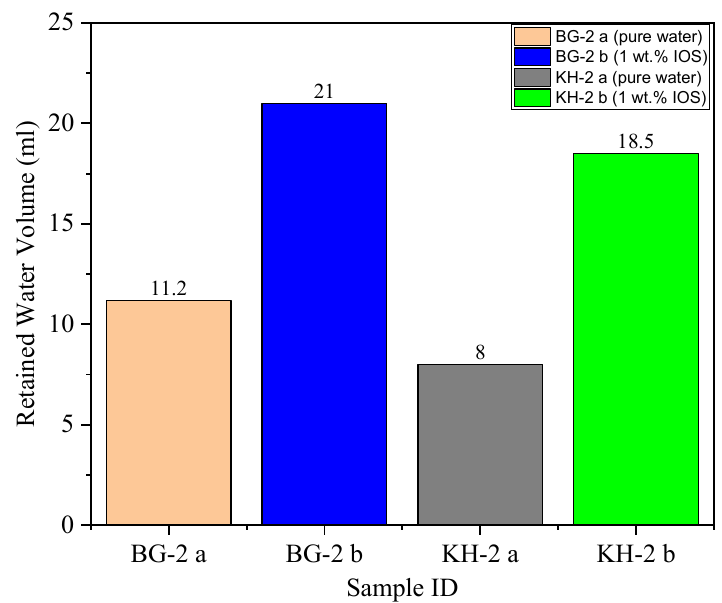
Figure 9. Water uptakes volume in BG-2 and KH-2 shales.